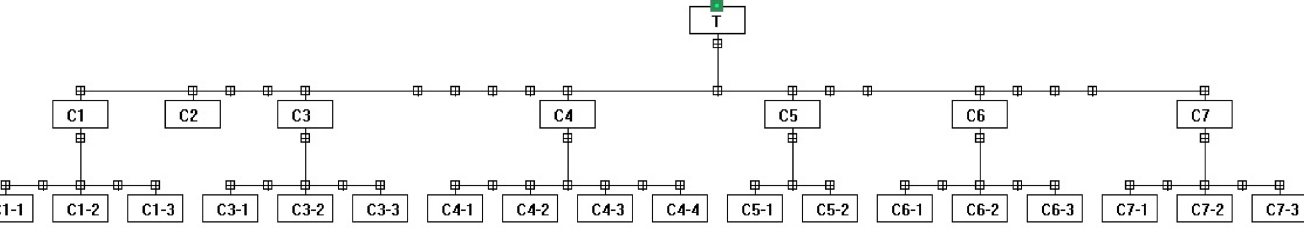
Fig 1. The criteria